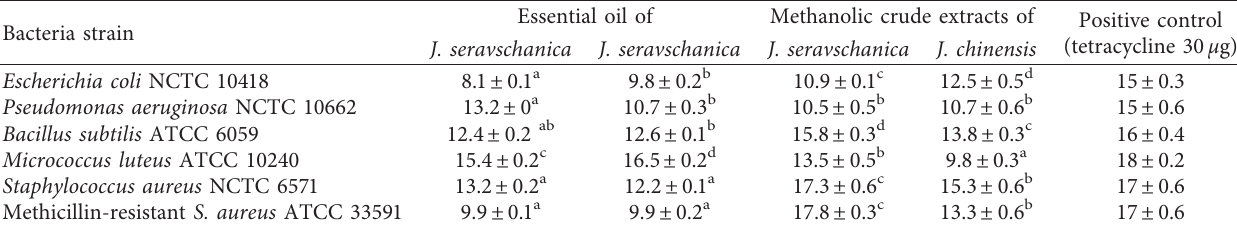
Table 2: Antibacterial activity of the J. seravschanica and J. chinensis essential oils and methanolic crude extracts (100 μ g) of J. seravschanica and J. chinensis measured using the disc diffusion method against six bacterial strains. Each cell with different alphabet subscribes across each row was significantly different ( p < 0 . 05) based on Tukey HSD post hoc analysis.